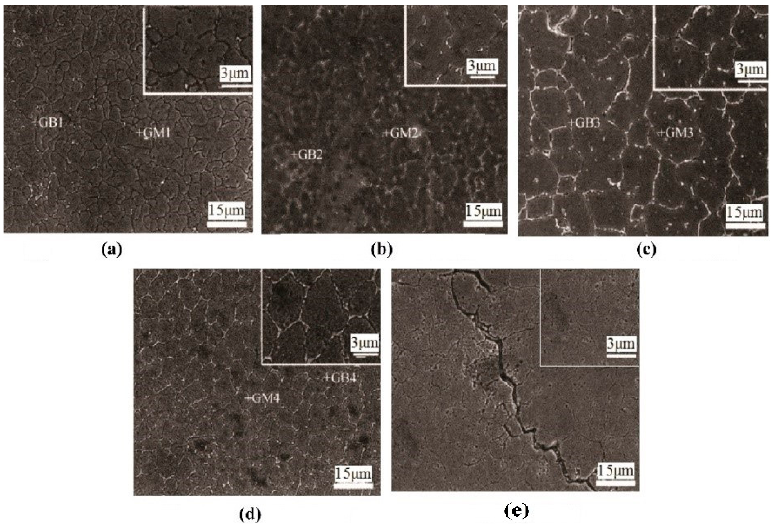
Figure 3. Microstructure of Al 0.7 FeCoCrNiCu x high-entropy alloy coatings with different Cu con-tents. ( a ). Al 0.7 FeCoCrNiCu 0.30 ; ( b ). Al 0.7 FeCoCrNiCu 0.60 ; ( c ). Al 0.7 FeCoCrNiCu 0.80 ; ( d ). Al 0.7 FeCoCrNiCu 1.0 ; ( e ). Al 0.7